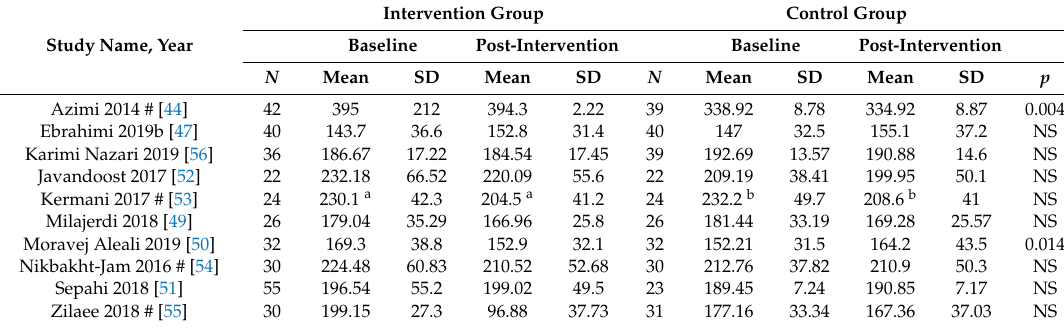
Table 4. Summary of findings for total cholesterol (t-chol).